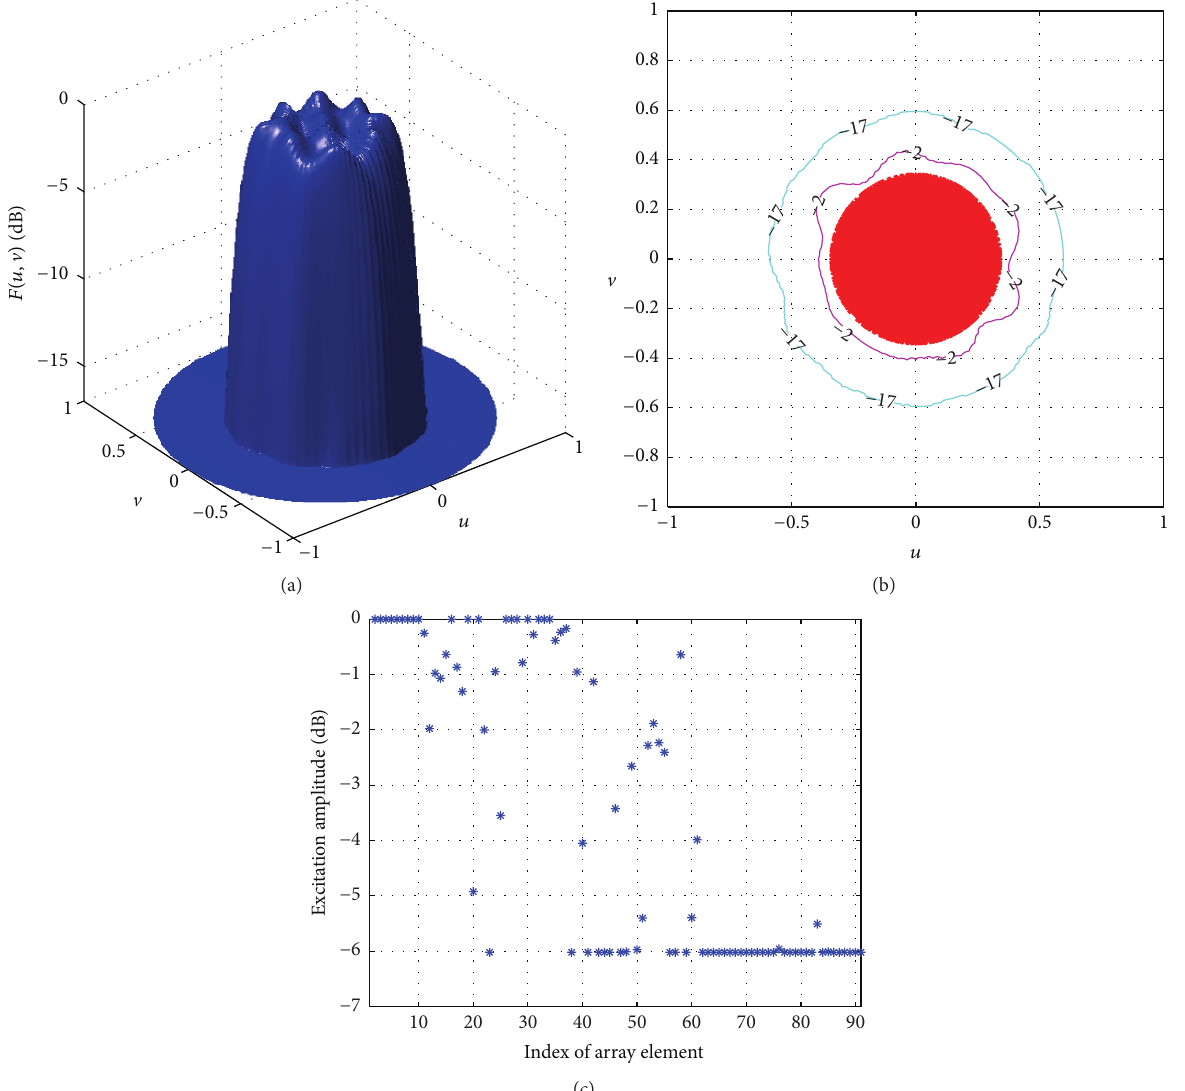
Figure 6: Synthesis result of pattern 1 for planar array. (a) The synthesized pattern, (b) the contour plot, and (c) the normalized excitation